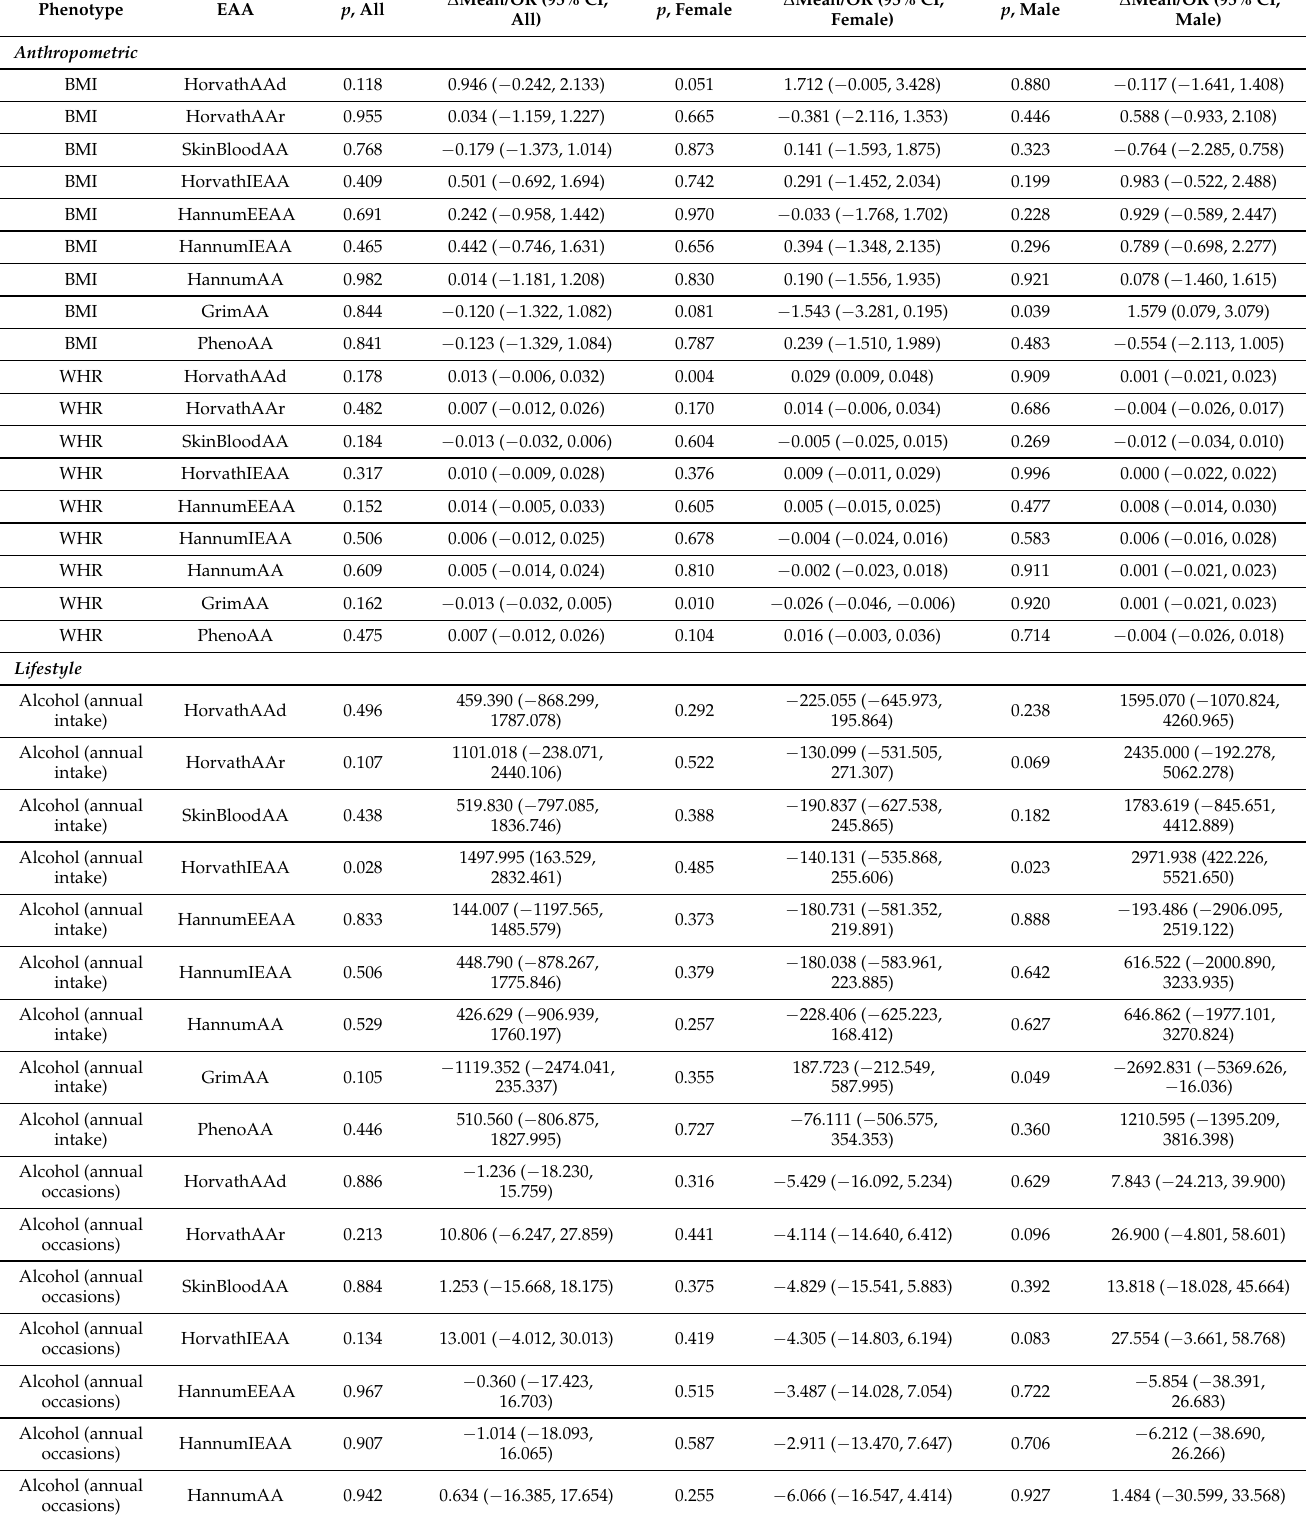
Table A6. All results for EAA − and EAA + groups for adjusted for sex EAA scores. For Welch’s t -test, group 1 is EAA − and group 2 is EAA + . For Fisher’s exact test, odds ratios depend on the phenotype value and grouping for the first sample in our